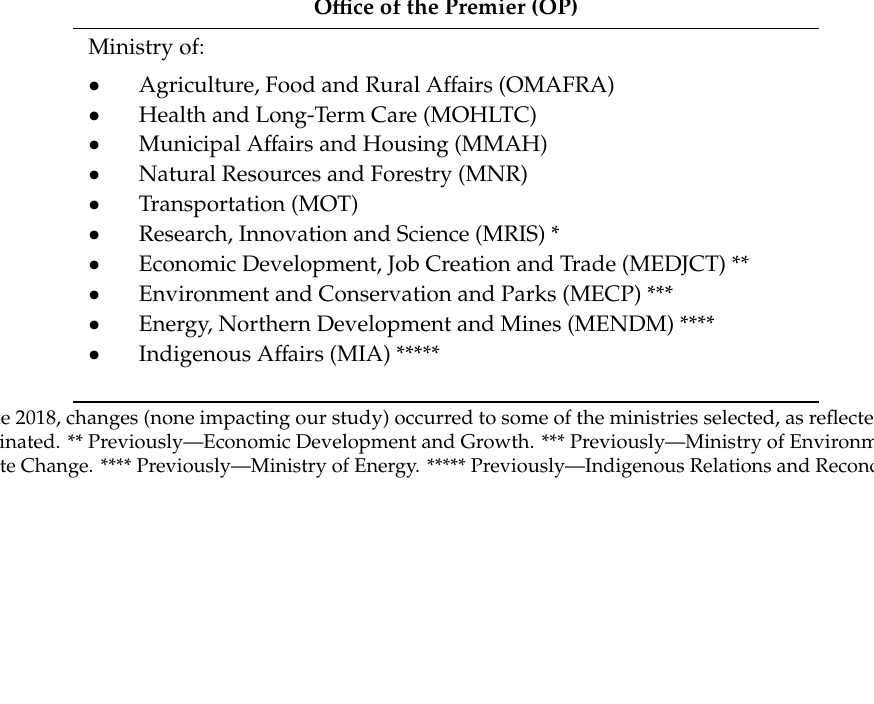
Table 1. Case study sample from provincial agencies O ffi ce of the Premier